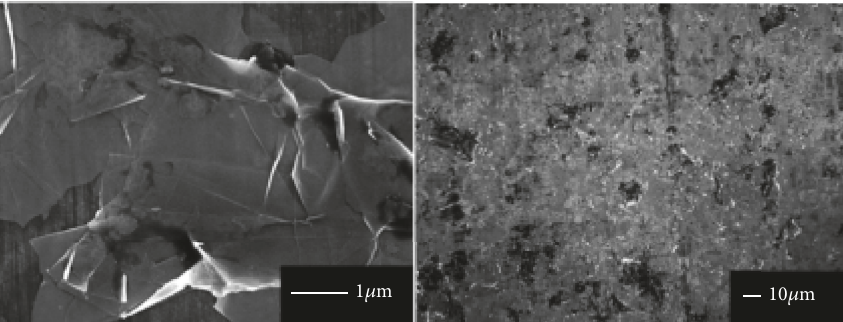
Figure 7: SEM images taken by the supplier of the graphene coated aluminum [9]. Although the 1 𝜇 m resolution of one the suppliers images is greater than what the AFM can accurately image, the flake-like structures clearly resemble each other.